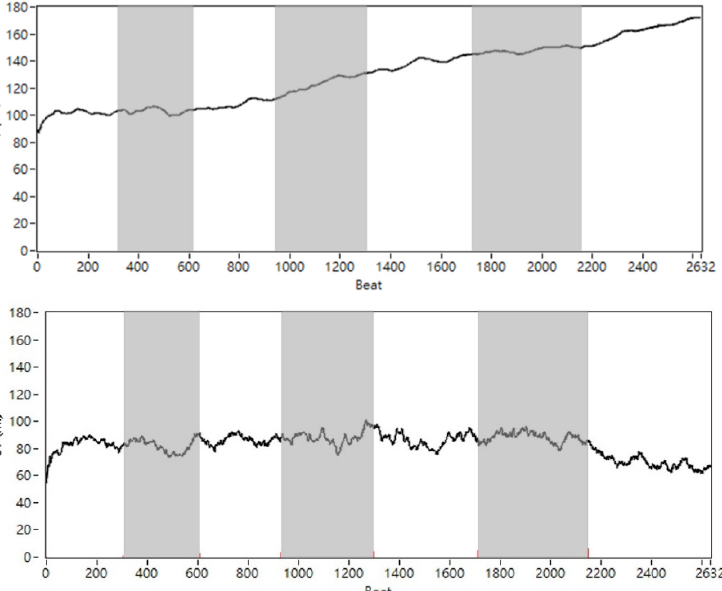
Figure 2. The demonstration of modified beat-domain HR and SV from patient #9. The white and gray blocks represent each sequence stage.